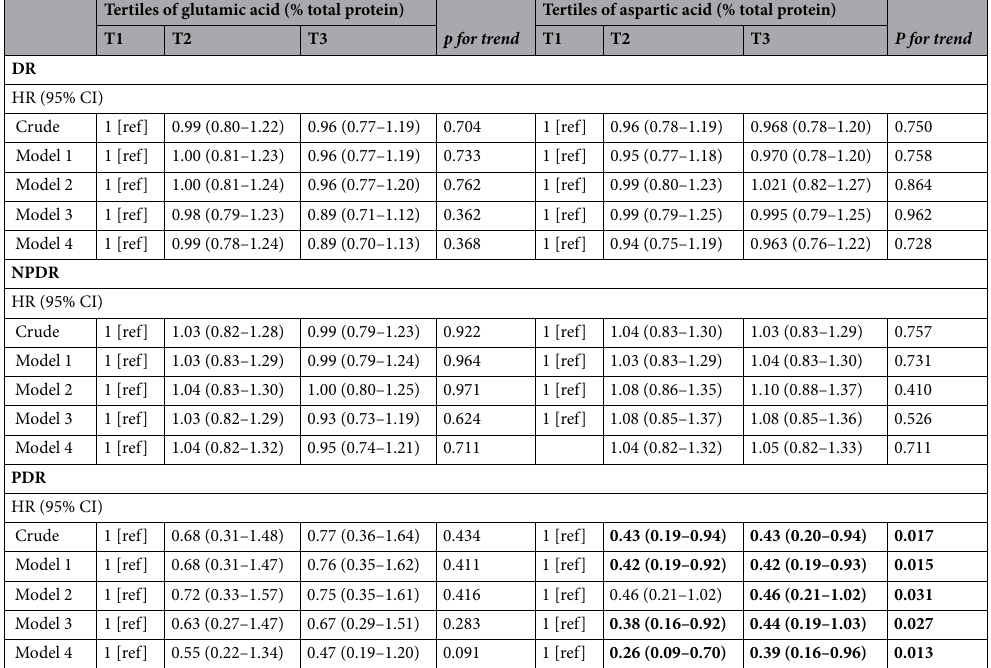
Table 4. Hazard ratio for diabetic retinopathy incidence according to tertiles of glutamic acid and aspartic acid intake (% total protein). By Cox proportional hazard models. DR diabetic retinopathy; NPDR isolated non-proliferative diabetic retinopathy; PDR proliferative diabetic retinopathy. *Model 1, adjusted for age and sex. **Model 2, adjusted for Model 1 + HbA1C, duration of diabetes mellitus. ***Model 3, adjusted for Model 2 + education, income, occupation. ****Model 4, adjusted for Model 3 + CrCl, ALT,